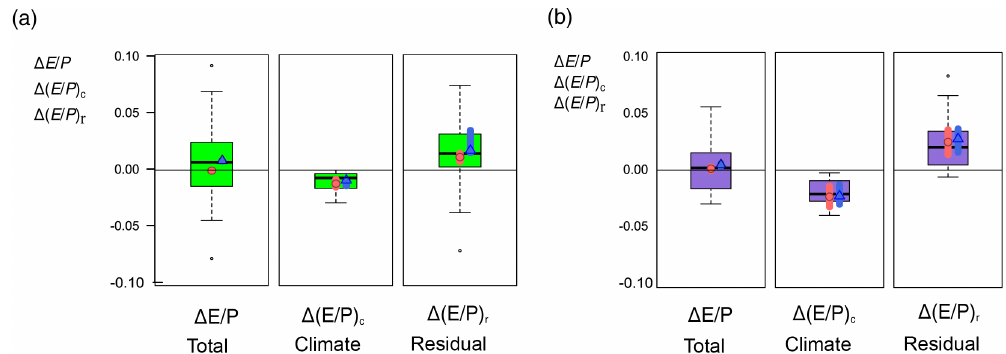
Figure 6. Climate and residual effects on the evaporative ratio. Distribution of changes from 1961–1986 to 1987–2012 in the evaporative ratio, (cid:49)E/P , and its climatic, (cid:49)(E/P) c , and residual, (cid:49)(E/P) r , effect components in the (a) boreal and (b) temperate groups of basins. Boxplot statistics include arithmetic mean (blue triangles), area-weighted mean (pink circles), median (thick horizontal black line), interquartile range √ N , where N is the number of basins in each biome group) and outliers (small (IQR) (boxes), whiskers (confidence interval of ± 1.58 × IQR black circles). Corresponding uncertainty ranges of the calculated arithmetic and area-weighted means of (cid:49)E/P , (cid:49)(E/P) c and (cid:49)(E/P) r for each basin group are shown as blue and pink vertical ranges of uncertainty, respectively. These uncertainty ranges arise from the use of three different precipitation and potential evapotranspiration data